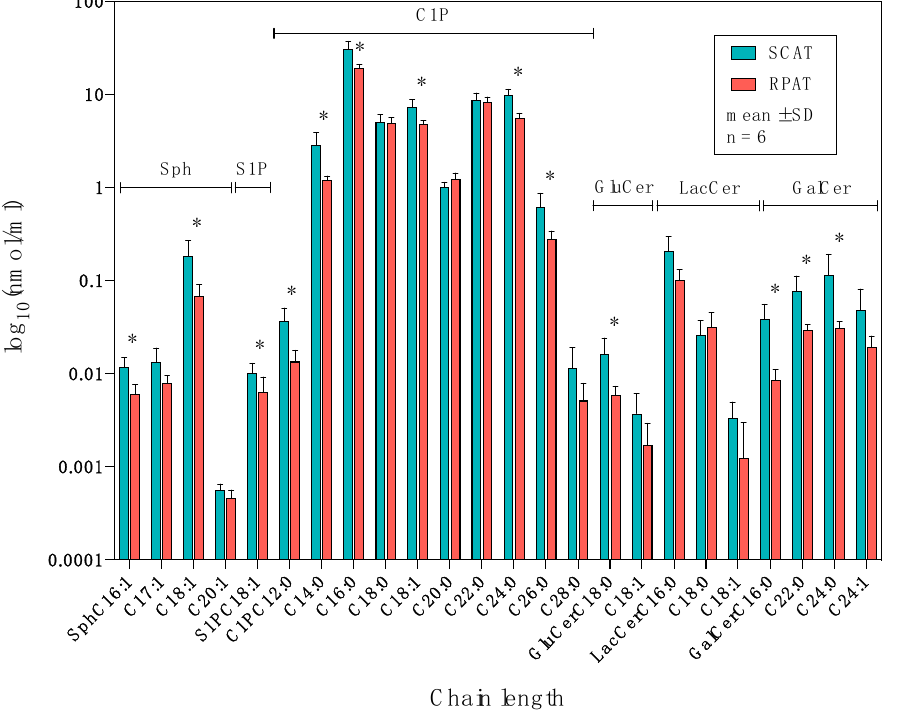
Figure 5. The distribution of sphingolipids in the salvage pathway in subcutaneous (SCAT) and retroperitoneal adipose tissue (RPAT) in German Holstein bulls ( n = 6). Data are presented as the mean ± standard deviation (SD) on a logarithmic scale. Sph: sphingosine concentration; S1P: sphingosine-1-phosphate concentration; C1P: ceramide-1-phosphate concentration; GluCer: glucosylceramide concentration; LacCer: lactosylceramide concentration; GalCer: galactosylceramide concentration. Asterisks indicate significant differences (* p < 0.05) between two adipose tissues by paired Student’s t -test with FDR correction.